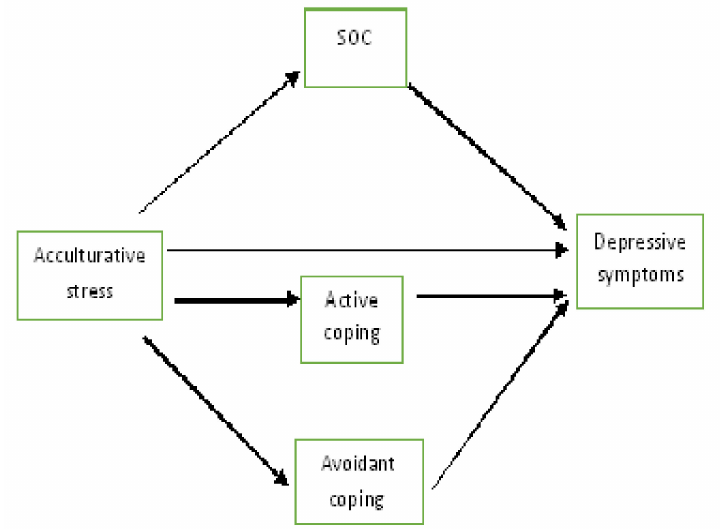
Figure 1. The hypothesized relationships between acculturative stress, avoidant coping, active coping, SOC, and depressive symptoms. SOC: Sense of